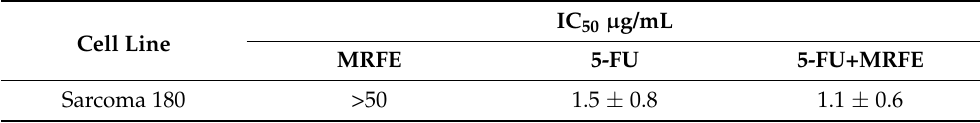
Table 1. Evaluation of MRFE in the interference in the in vitro antitumor activity of the 5-FU. IC 50 µ g/mL Cell Line MRFE